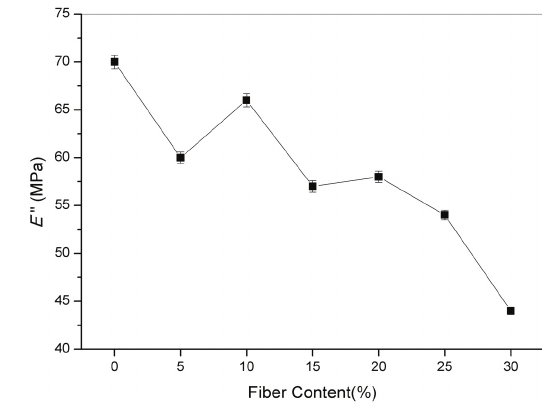
) versus fiber content. ss